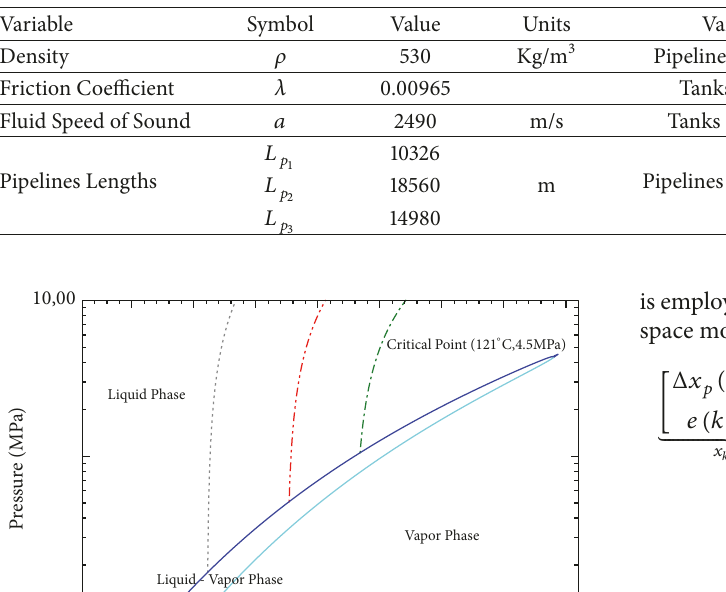
Figure 1: Liquefied Petroleum Gas pipeline. Table 1: Pipeline model parameters.